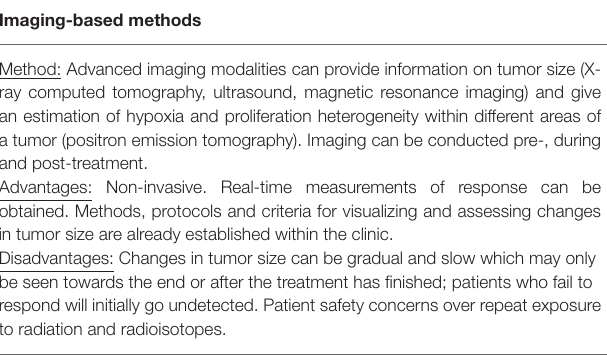
TABLE 1 | Techniques used for measuring the response of tumors to RT. Imaging-based